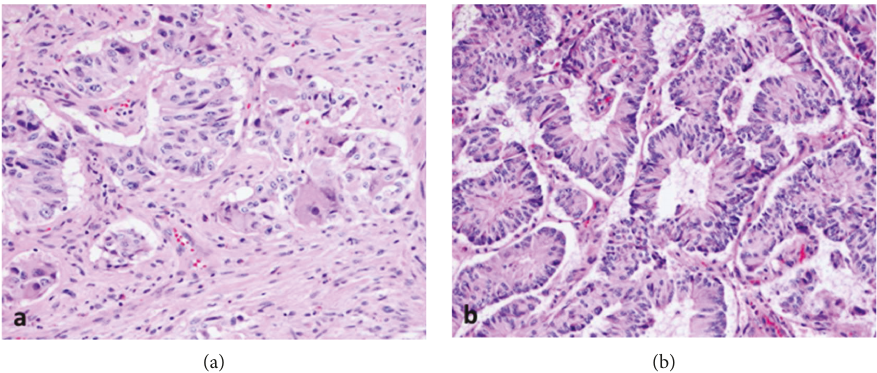
Figure 3: Hematoxylin and eosin (H&E) slides of our case report specimen, seen under low- and high-power magni fi cation in (a) and (b), demonstrating the presence of three di ff erent cell types: epithelioid cells, spindle cells, and ganglion-like cells.